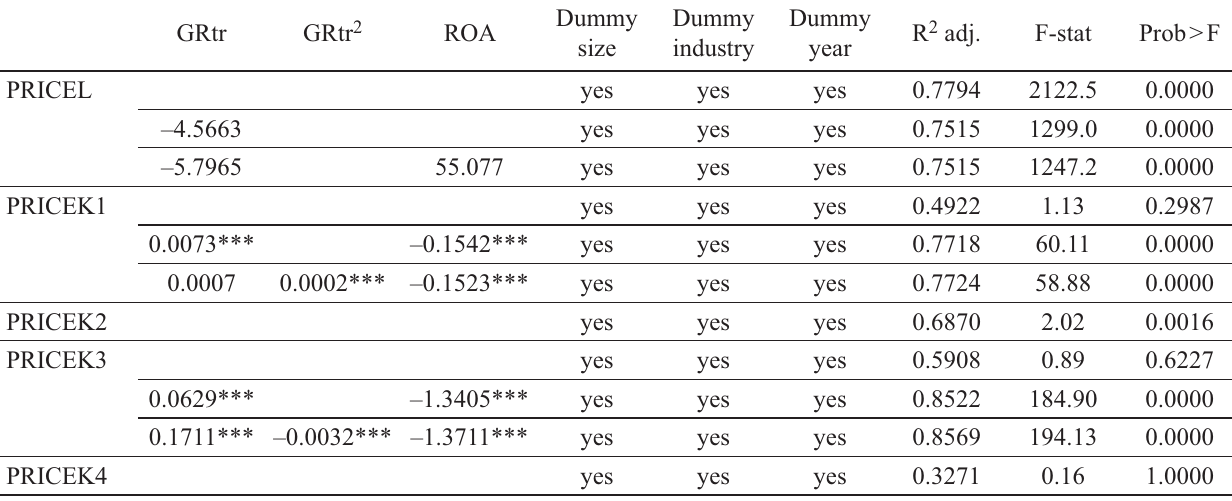
Table 7. Fixed effects models for the dependence of factor prices on the growth rate and control variables GRtr GRtr